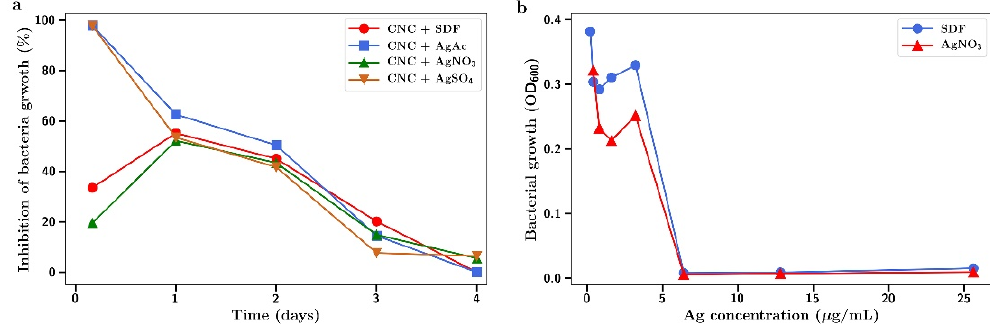
Figure 10. Inhibition of MRSA growth by ( a ) release media from incubation of SDF or silver salt crosslinked CNC at 4 h, 1, 2, 3, and 4 days; ( b ) MRSA growth as a function of silver concentration using SDF or silver nitrate in solution.